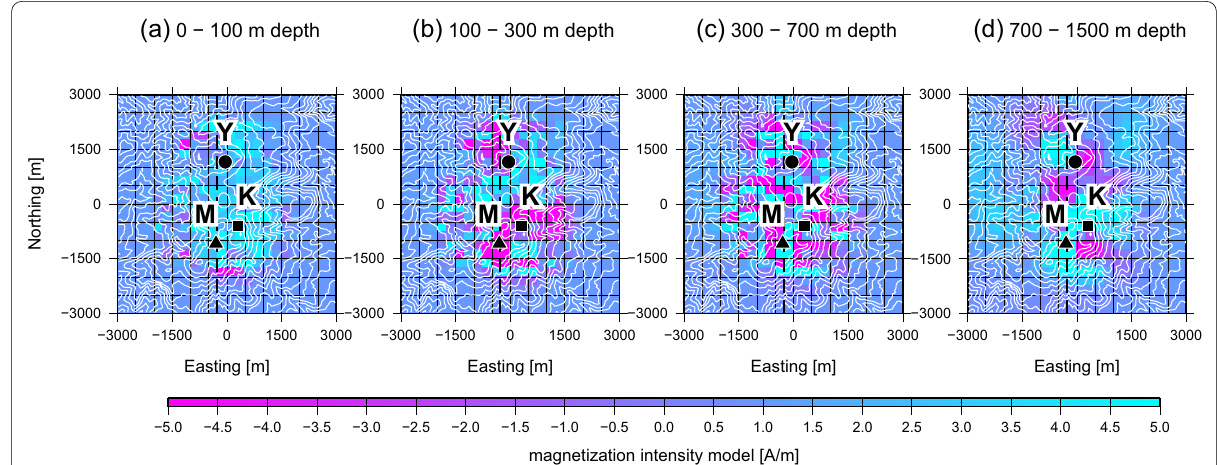
Fig. 3 Magnetization intensity model in Kusatsu-Shirane volcano. The closed circle with “Y”, square with “K”, triangle with “M” are the crater lake Yugama of Mt. Shirane, Kagamiike-kita crater, and the main crater of Mt. Motoshirane, respectively. Note that a surrounding area is not shown because of no model resolution, although an inverted area is much